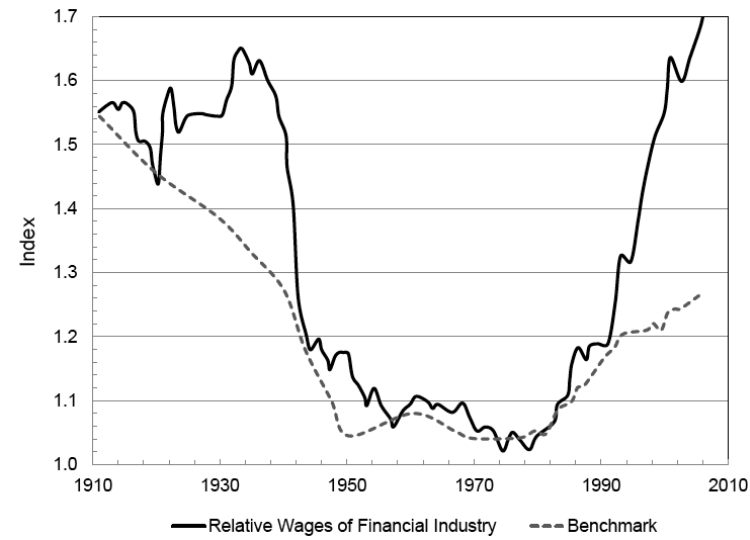
Figure 7. Actual and benchmark relative wages in the financial industry